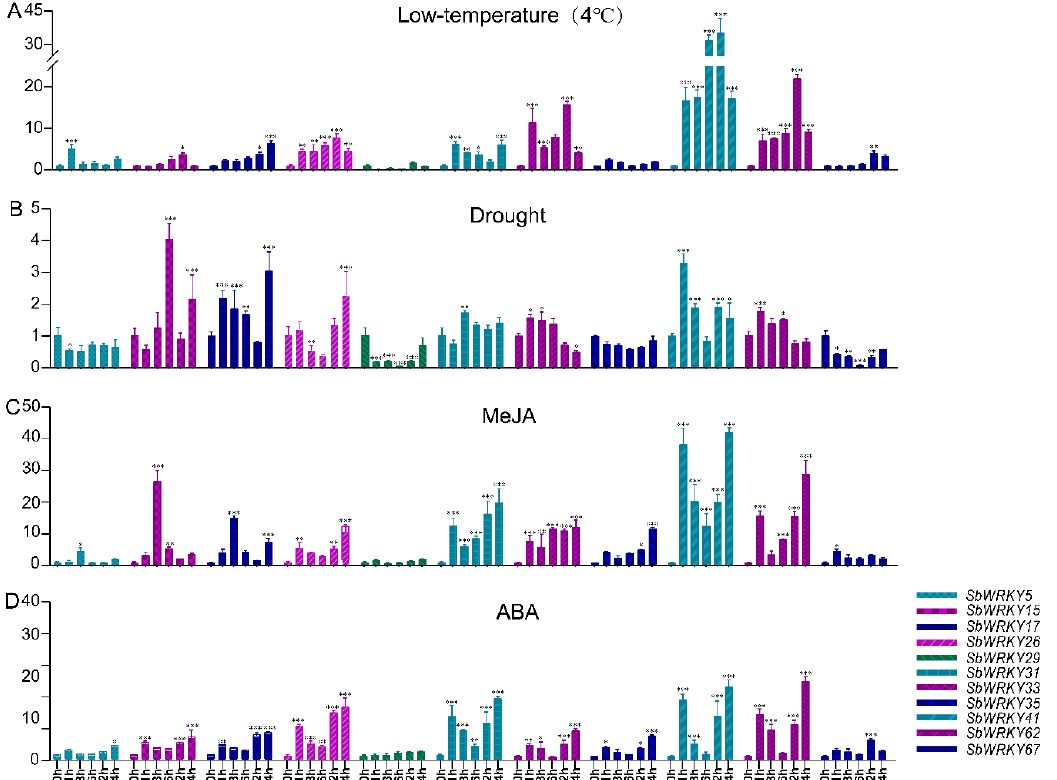
Figure 9. Expression profiles of SbWRKY genes under different stress treatments at 0, 1,3,6,12, and 24 h. ( A ) 4 °C. ( B ) Drought. ( C ) MeJA. ( D ) ABA. The data were normalized to the SbACT2 gene and